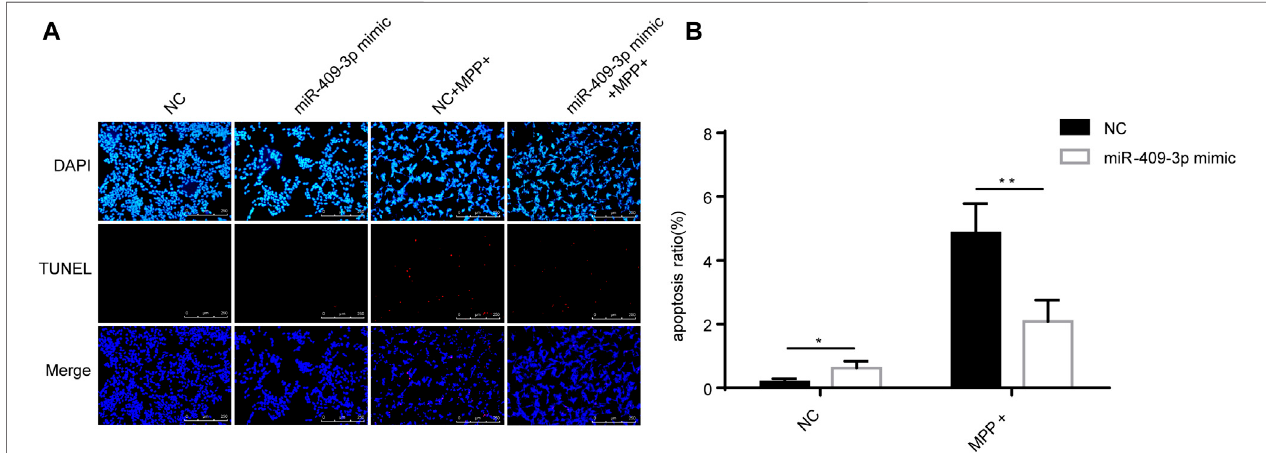
Frontiers in Cell and Developmental Biology |